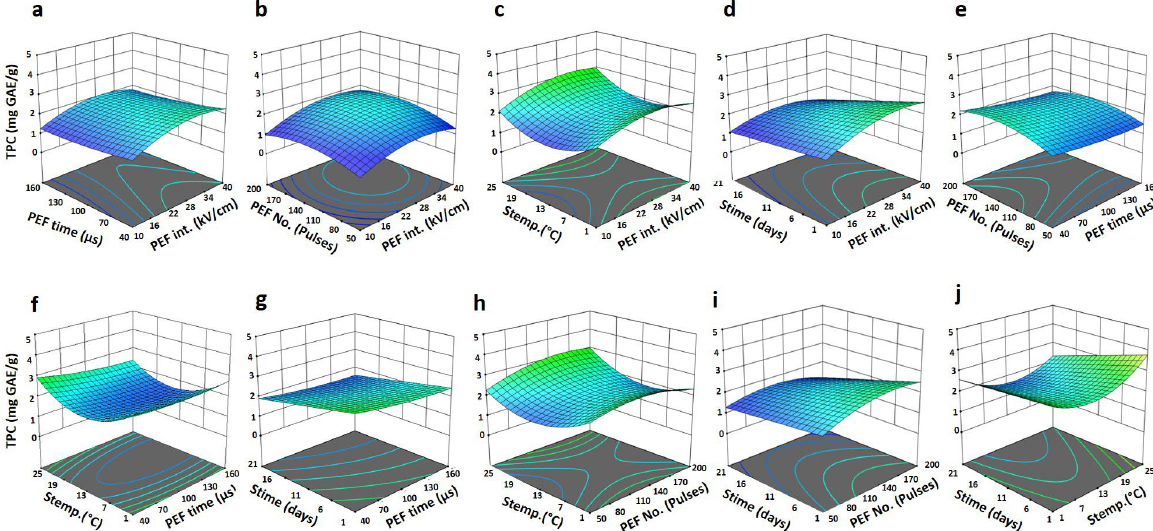
Figure 6. Response surface plots of total phenolic content (TPC) of Barhi dates as a function of PEF time and PEF intensity ( a ), PEF number of pluses and PEF intensity ( b ), storage temperature and PEF intensity ( c ), storage time and PEF intensity ( d ), PEF number of pulses and PEF time ( e ), storage temperature and PEF time ( f ), storage time and PEF time ( g ), storage temperature and PEF number of pulses ( h ), storage time and PEF number of pulses ( i ), and storage time and storage temperature ( j ).